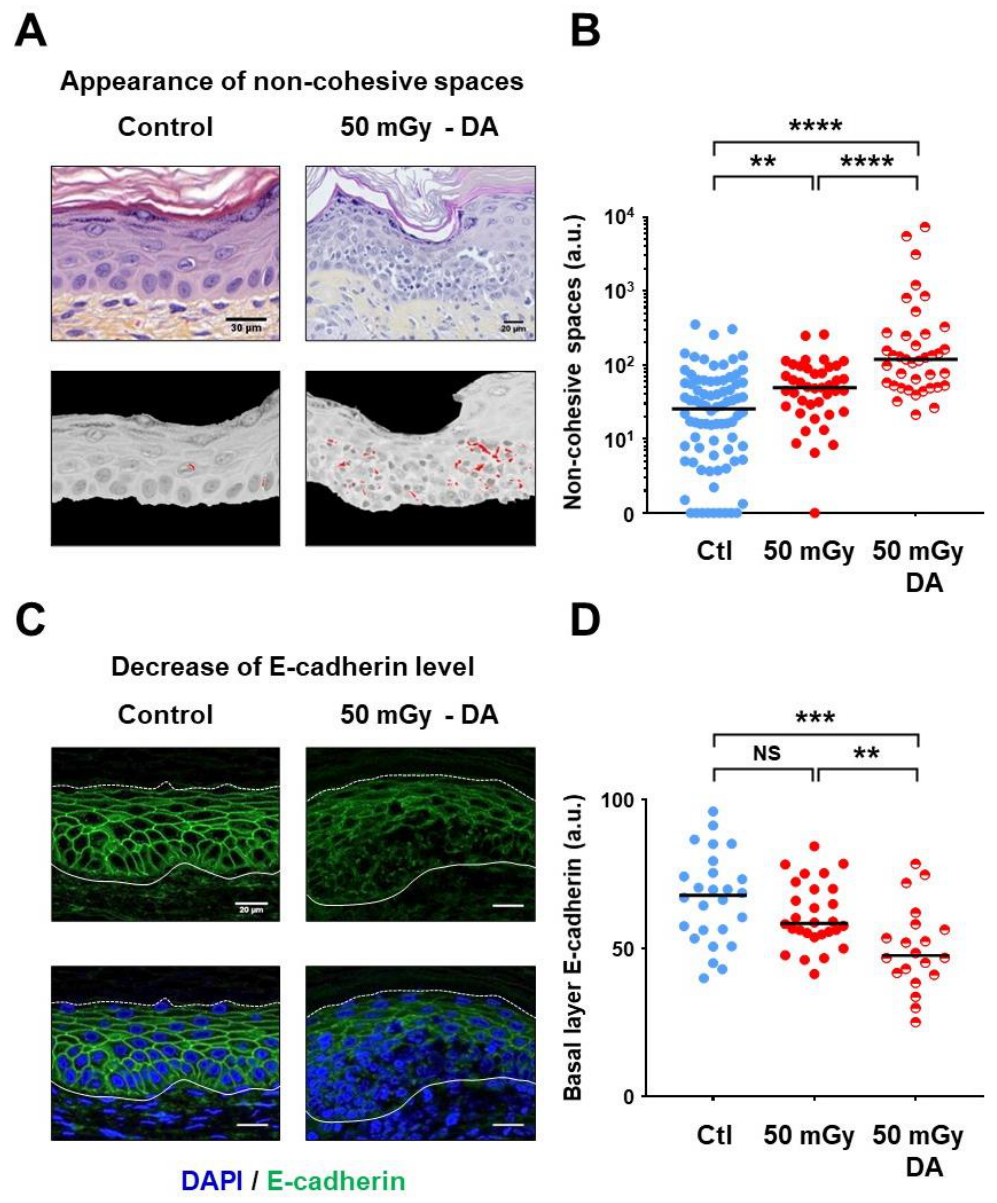
Figure 4. Defective cell-cell cohesiveness in dysplastic areas. ( A ) Typical pictures of HES sections illustrating cohesive epidermis in normal regions and the presence of visible non-cohesive spaces within DAs (top panel). Conversion of spaces into red pixels by automated image processing (bottom panel) for semi-quantitative analysis. ( B ) Semi-quantitative analysis of non-cohesive spaces based on red pixel conversion (arbitrary units, a.u.), revealing the presence of significant non-cohesive zones in DAs. Dot plots cumulated the analyses of 82 normal regions from control (Ctl) xenografts, 41 random regions from the 50 mGy xenografts and 39 selected regions corresponding to DAs in the 50 mGy xenografts. Bars correspond to median values (** p < 0.01; **** p < 0.0001, Mann–Whitney U test). ( C ) Immunofluorescence detection of E-cadherin. Representative pictures were selected for the visualization of E-cadherin expression in normal epidermis regions, showing its decrease or absence in basal keratinocytes from DAs. Nuclei were colored with DAPI. ( D ) Semi-quantitative analysis of E-cadherin (arbitrary units, a.u.), showing a lower signal within DAs. Dot plots cumulated the analyses of 26 normal regions from the 14 control (Ctl) xenografts and 20 DAs from the 14 xenografts of the 50 mGy condition. Bars correspond to median values (NS p > 0.05; ** p < 0.01; **** p < 0.0001, Mann–Whitney U